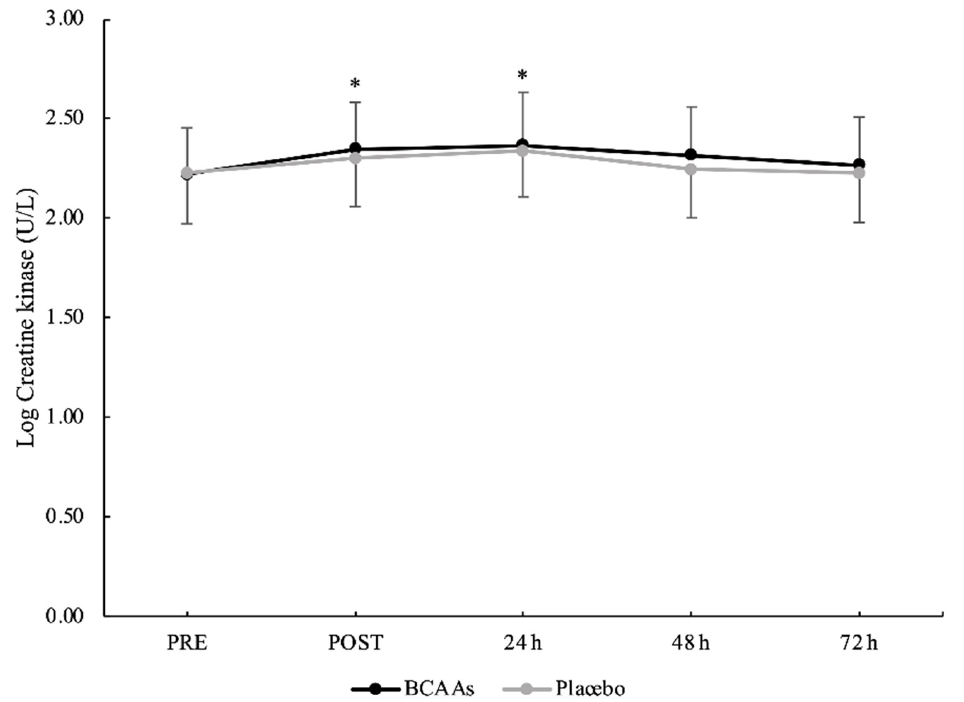
Figure 3. Creatine kinase serum activity with logarithmic transformation during the time course of recovery. (*) Denotes differences ( p < 0.05) from PRE.